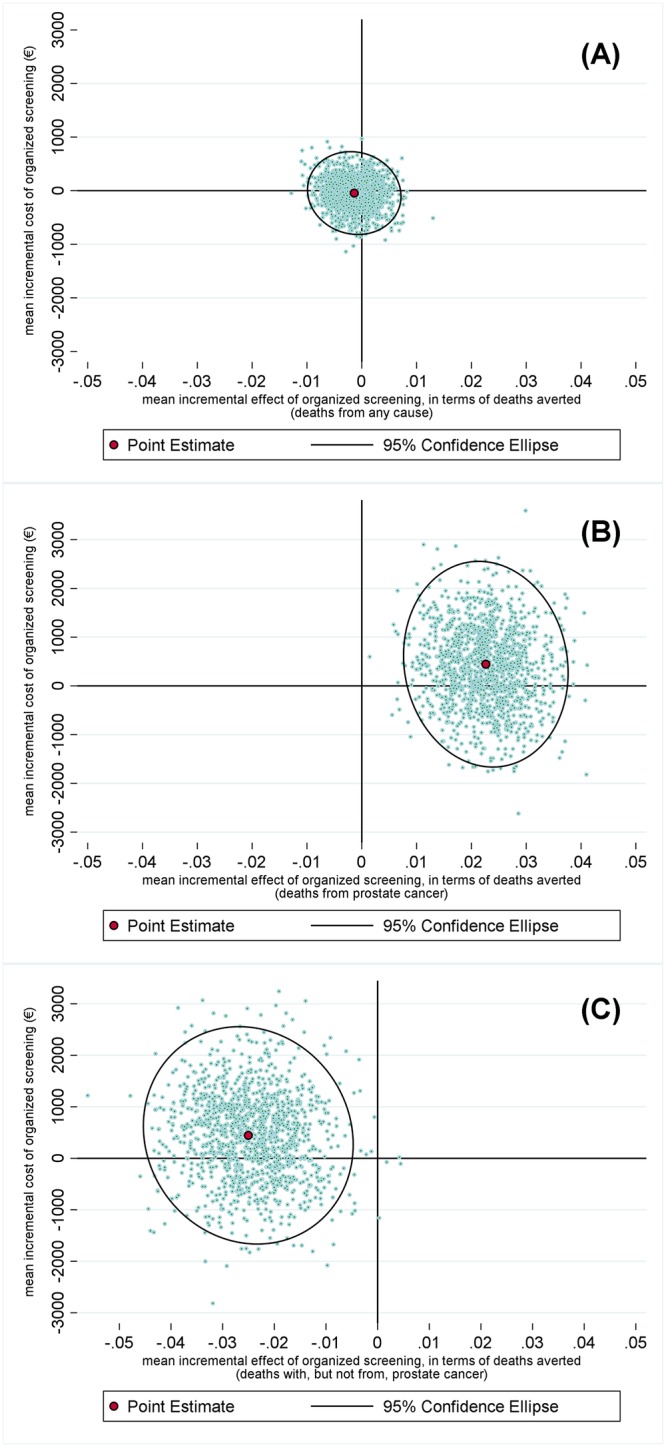
Scatterplots of bootstrap replications of incremental cost-effectiveness ratios in terms of the number of deaths.Panel (A): Estimates of incremental cost-effectiveness ratios in terms of death from any cause (for all men in the trial). Panel (B): Estimates of incremental cost-effectiveness ratios in terms of death from prostate cancer (for men diagnosed with prostate cancer). Panel (C): Estimates of incremental cost-effectiveness ratios in terms of death from causes other than prostate cancer (for men diagnosed with prostate cancer).